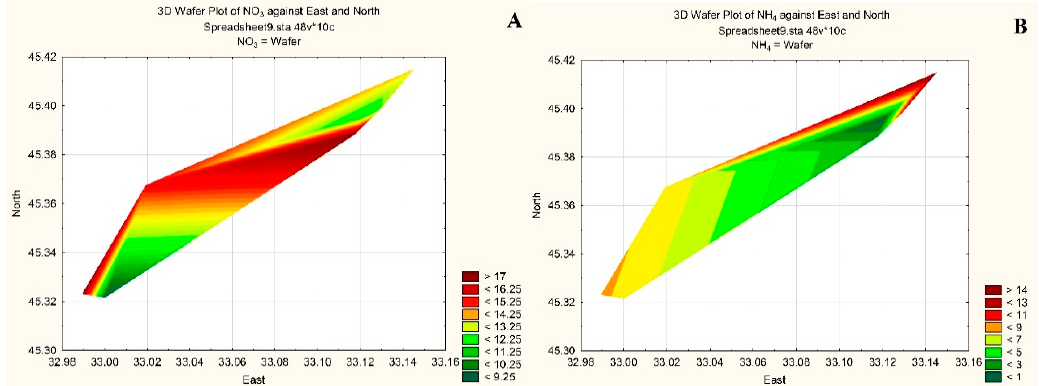
Figure 8. Concentrations of dissolved nitrates ( A ) and ammonium ( B ) in the water column at the sampling stations in the Donuzlav Gulf of the Black Sea.